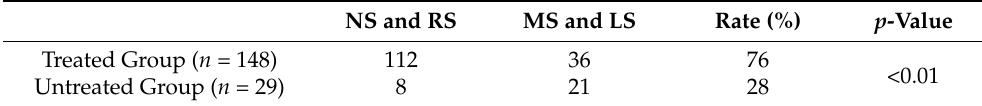
Table 5. The AEEG outcomes of epilepsy patients after surgery at the long-term follow-up. NS and RS MS and LS Rate (%) p -Value Treated Group ( n = 148)